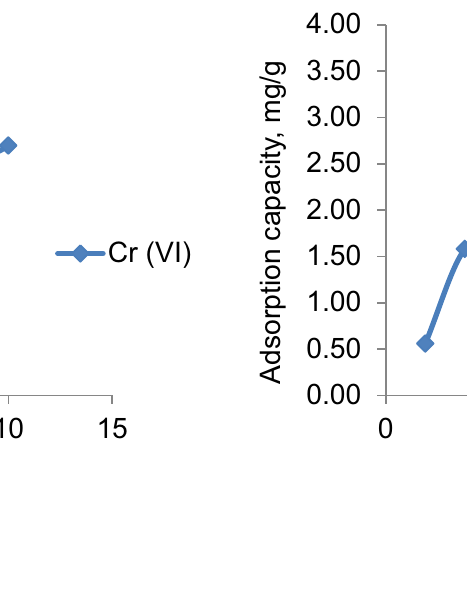
Fig. 3 Effect of pH on the adsorption of Cr(VI) ion